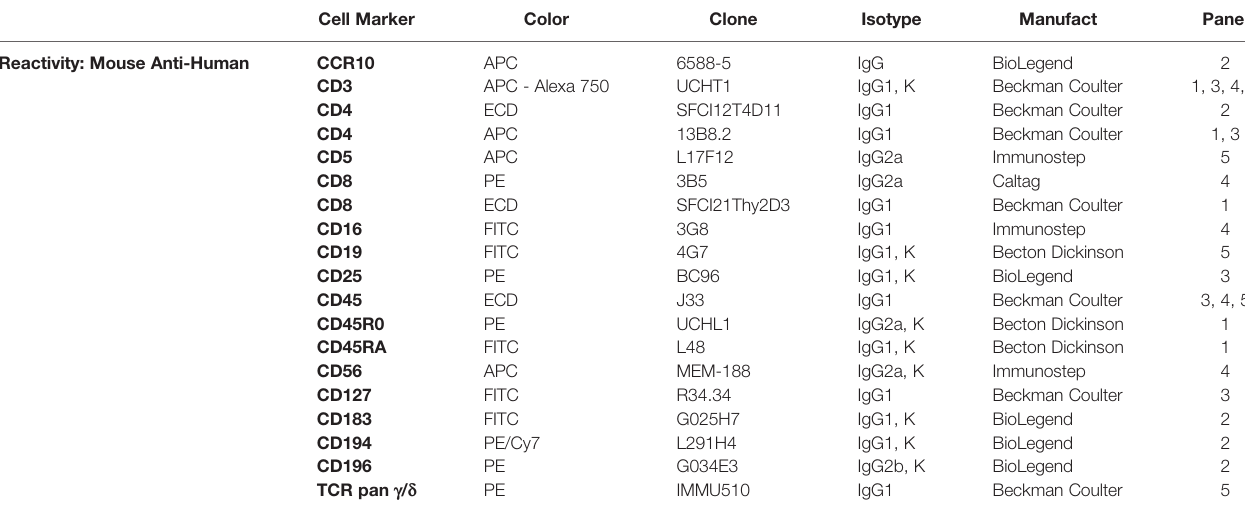
TABLE 2 | Description of monoclonal antibodies